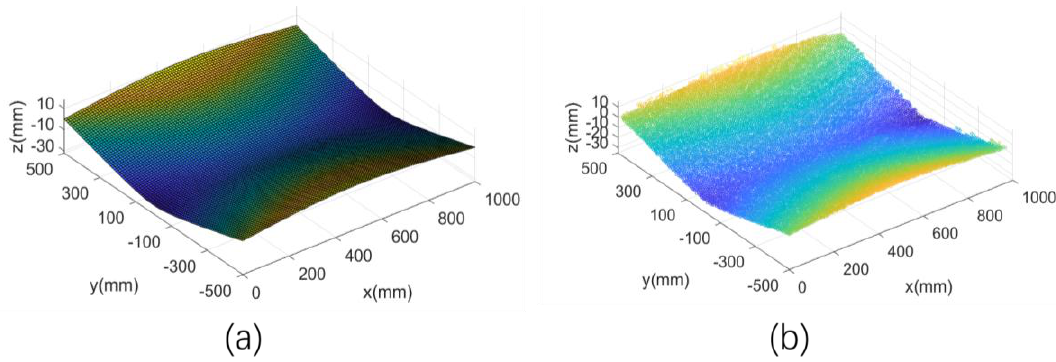
Figure 7. Deformation of the plate: ( a ) FEM calculation result; ( b ) experimentally measured result. Appl. Sci. 2020 , 10 , 2304 9 of 17